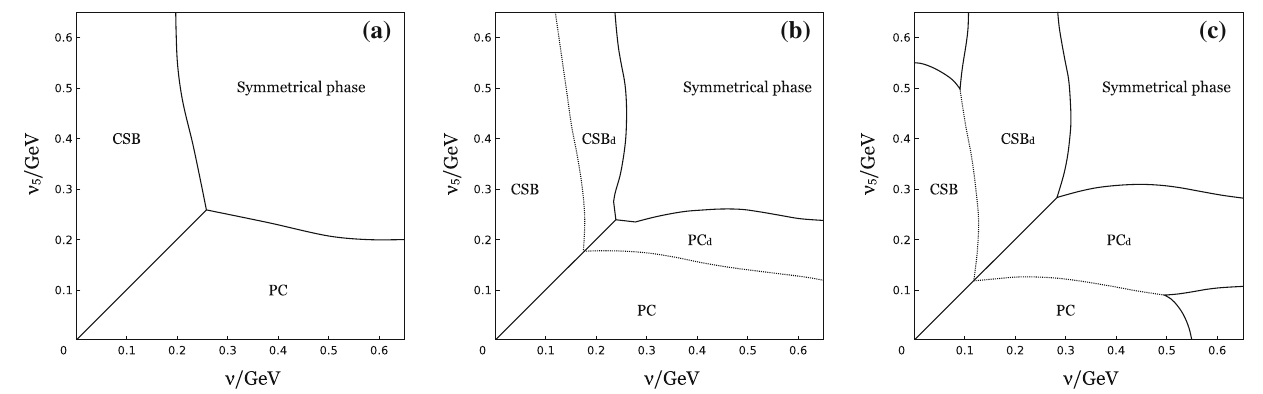
Fig. 1 The (ν,ν 5 ) -phase portraits of the model in the chiral limit ( m 0 = 0 ) for μ = 0MeV – ( a ); μ = 150MeV – ( b ); and μ = 200MeV – ( c ). Notations are presented in Sect.